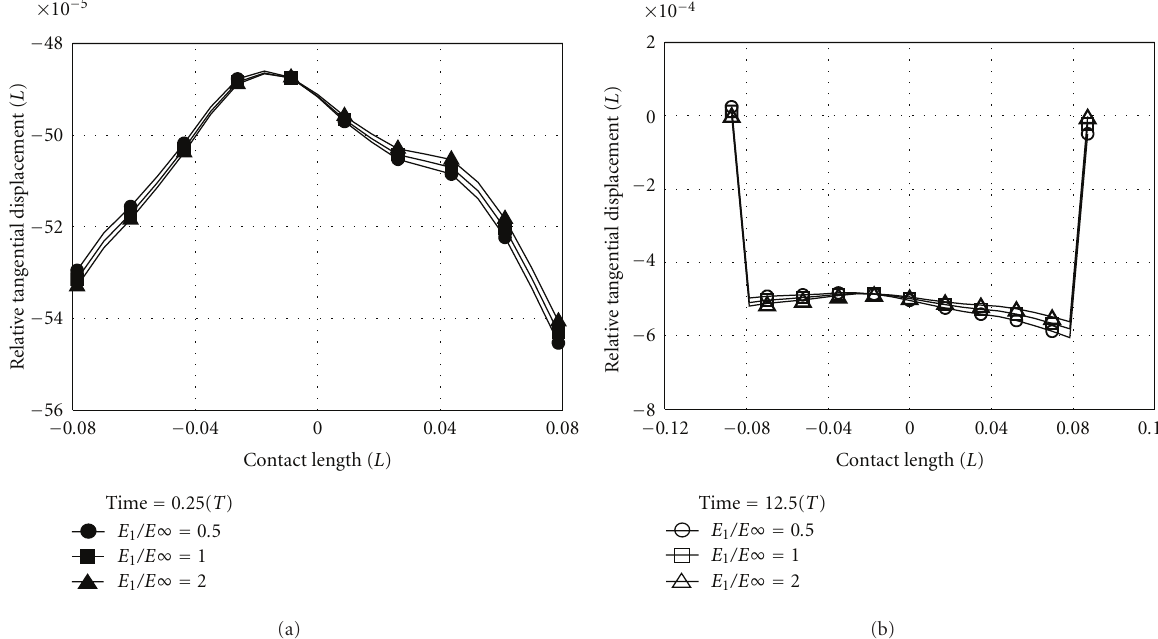
Figure 14: E ff ect of E 1 /E ∞ on the relative tangential displacement distribution.